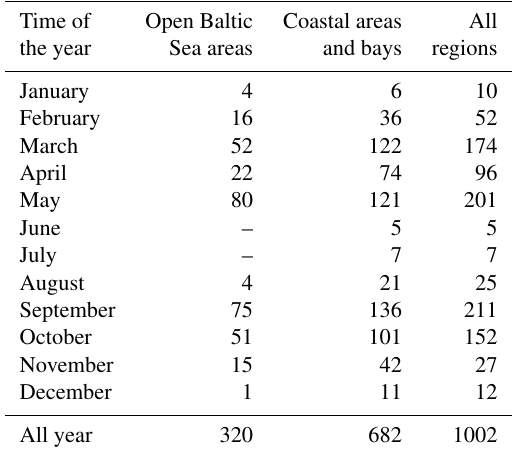
Table 1. Numbers of seawater samples analysed, divided into the months and areas of their